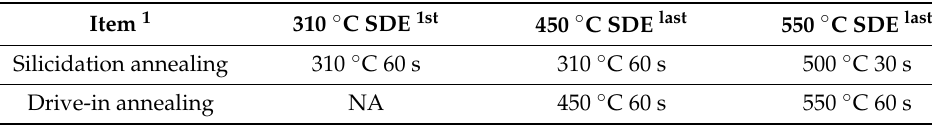
Figure 1. ( a ) Process flow of Schottky S/D FinFETs in this work, ( b ) Schematic layout and cross section of the complementary Schottky S/D FinFETs inverter, ( c ) Standard high-temperature process flow of conventional device. Table 1. Split of thermal budget for SDE